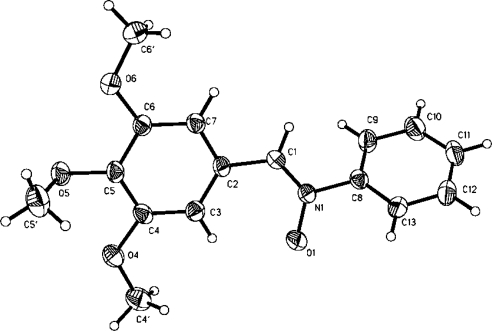
ORTEP of nitrone 3i.